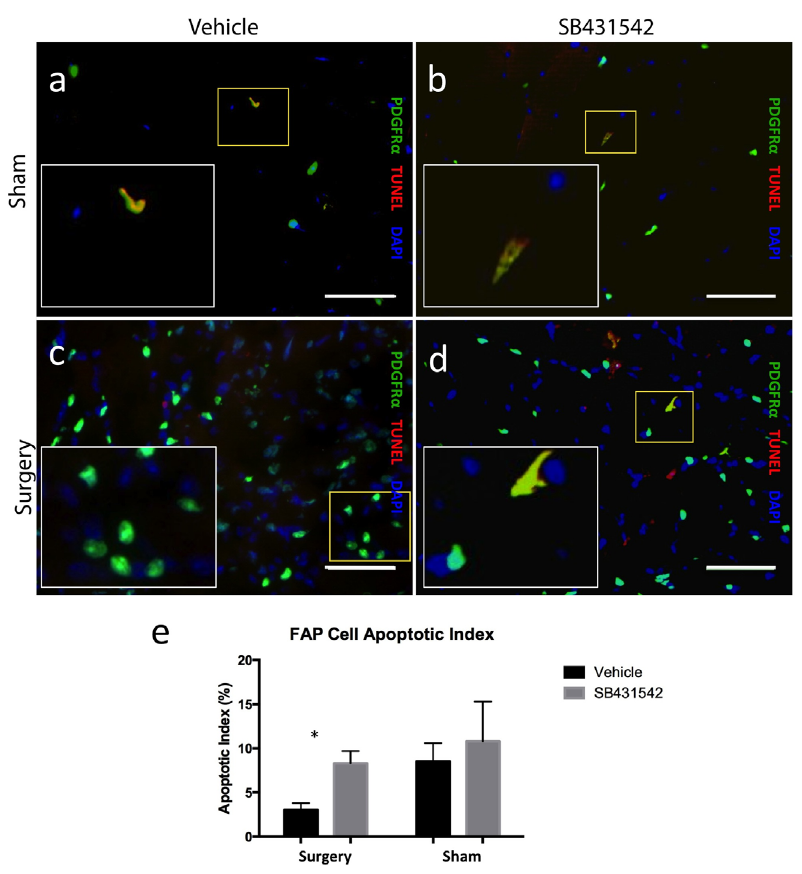
Fig 7. SB431542 promotes FAP cell apoptosis in injured rotator cuff muscle. (a-d) Representative fluorescent TUNEL assay of supraspinatus muscle from PDGFR α -GFP reporter mice, counterstained with DAPI, scale bar = 25 μ m; selection in yellow box enlarged in right lower corner. (e) ImageJ quantification of TUNEL+ cells (rhodamine) that co-express PDGFR α (GFP) from 4 representative fields of view imaged at 20X magnification from PDGFR α -GFP reporter mice (N = 3/group). * p <